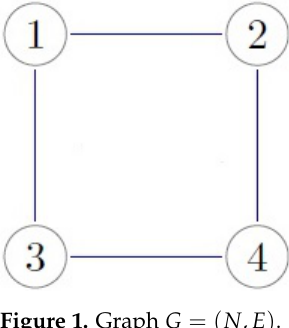
Figure 1. Graph G = ( N , E )